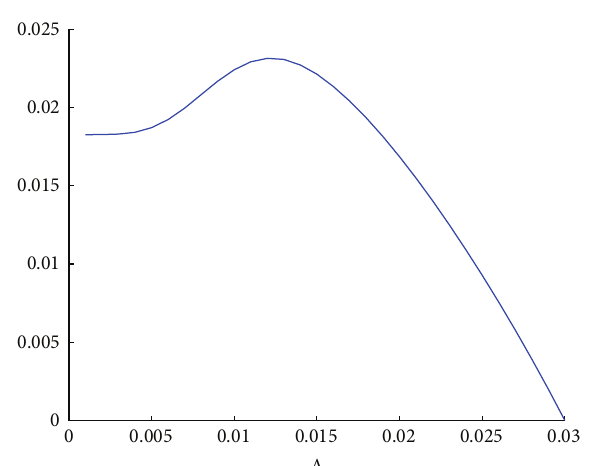
Figure 1: We illustrate here the dependence of 𝑃 Λ (𝜆 0 ) as a function of Λ ; this allows for finding the optimal value Λ ∗ that maximizes the option price. For the numerical example described here we obtain Λ ∗ = 123 bps.